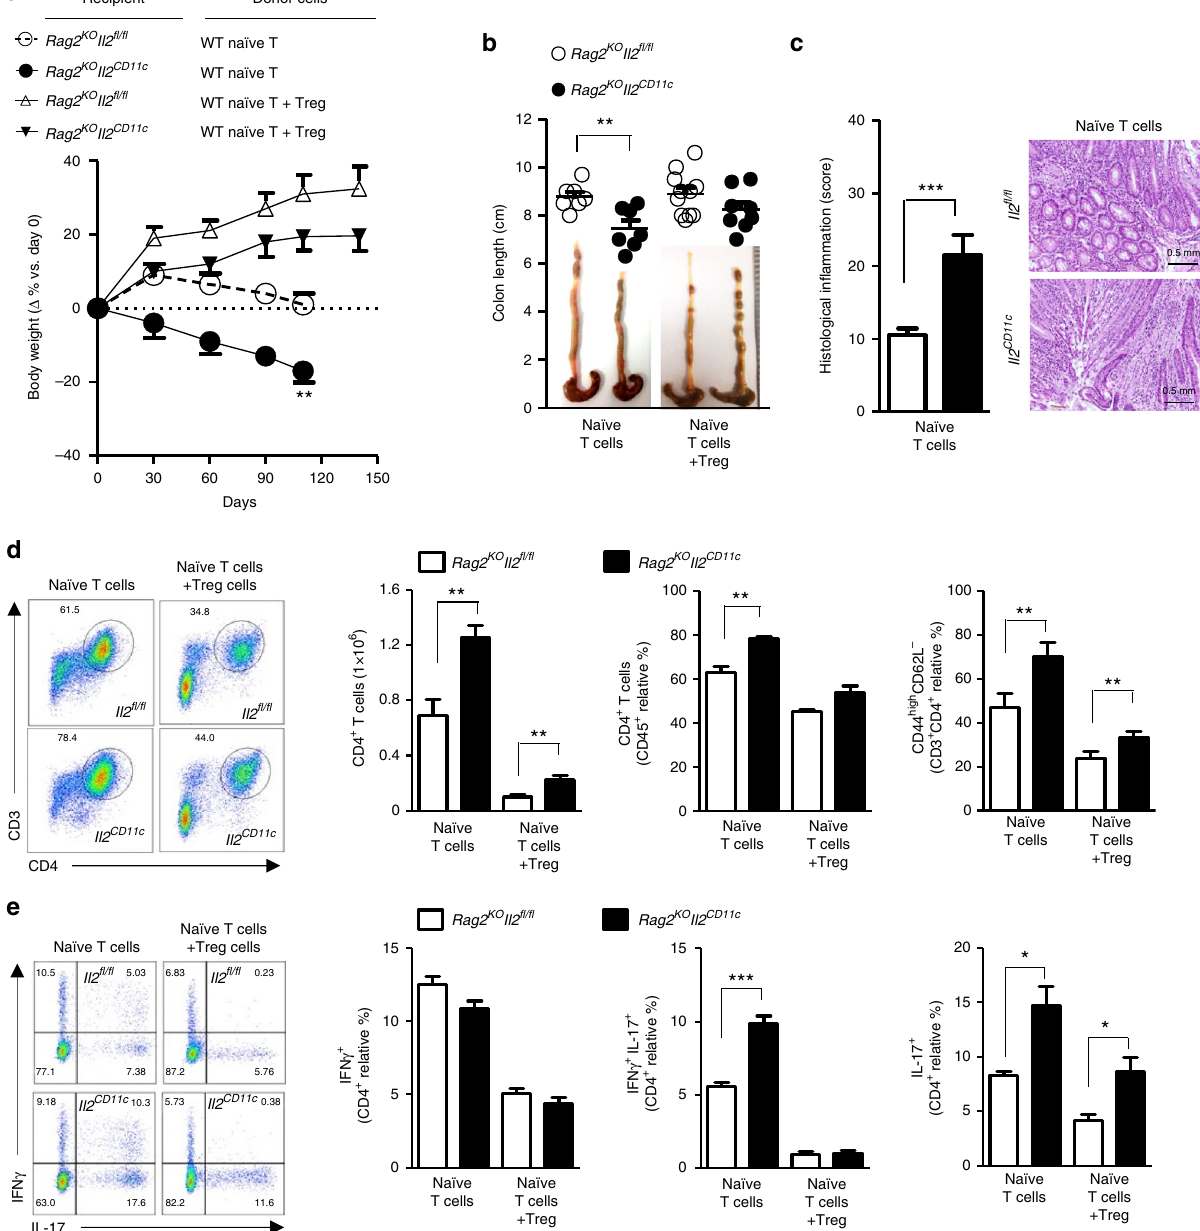
Fig. 7 DC-derived IL-2 suppresses pathogenic CD4 + T-cell expansion in the intestine. a Change in body weight and b severity of colitis based on colon length of Il2 CD11c and Il2 fl / fl , Rag2 knockout (KO) mice ( Rag2 KO IL - 2 fl / fl and Rag2 KO IL - 2 CD11c mice) adoptively transferred with naïve CD4 + T cells either alone or in combination with Treg cells isolated from spleens of C57BL/6 mice. Representative pictures of colons after adoptive T-cell transfer are shown. Data represent the means ± standard error of two experiments ( n = 2 – 5 mice/group per experiment). ** P < 0.01. c Histological in fl ammatory score based on H&E staining of colon sections (×10 magni fi cation, scale bar 0.5 mm) obtained from Rag2 KO Il2 fl / fl and Rag2 KO Il2 CD11c mice after 110 days of naïve CD4 + T- cell transfer. Data represent the means ± standard error. *** P < 0.001. d , e Phenotypic analysis of colonic lamina propria CD4 + T cells evaluated 110 days after adoptive T-cell transfer. The total number and the relative percentage of total and activated CD4 + T cells ( d ), as well as the proportions of CD4 + T cells producing IL-17, IFN γ or both ( e ) are shown. * P < 0.05, ** P < 0.01, *** P < 0.001. All data represent the means ± standard error of two experiments ( n = 3 – 4 mice/group per experiment) + + (Fig. 5f and Supplementary Fig. 9a, b). Moreover, intestinal MHCII DC population (predominantly restricted to the CD11c macrophage population (CD11c + MHCII + CD64 + F4/80 + / − ) was CD103 + cells) (Fig. 5g and Supplementary Fig. 9). negative for IL-2 labeling both during steady-state and colitic To examine whether de fi cient IL-2 expression in conditions (Fig. 5f and Supplementary Fig. 9a, b). IL-2 production CD11c high MHCII + DCs of Cnb1 CD11c mice was the key factor + + MHCII DCs, but not macrophages, was also involved in dysregulation of intestinal immune responses, we by CD11c con fi rmed by qRT-PCR (Supplementary Fig. 9c). These data administered IL-2:anti-IL-2 complexes (IL-2C), which increase indicate that IL-2 expression in vivo is high in the intestine and IL-2 bioactivity in vivo, and assessed whether normal intestinal NATURE COMMUNICATIONS | (2018) 9:1102 | DOI: 10.1038/s41467-018-03495-3 |